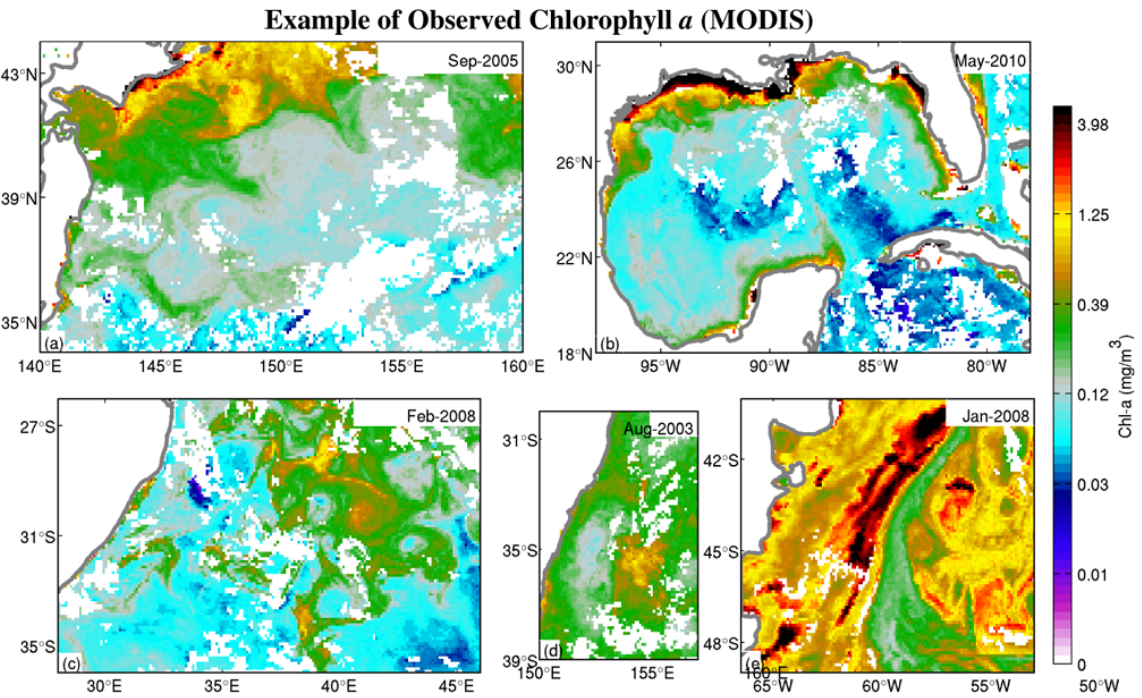
Fig. 17. Example of 8-day composite chlorophyll a from MODIS for the (a) Kuroshio, (b) Gulf of Mexico, (c) Agulhas, (d) EAC, and (e) BMC